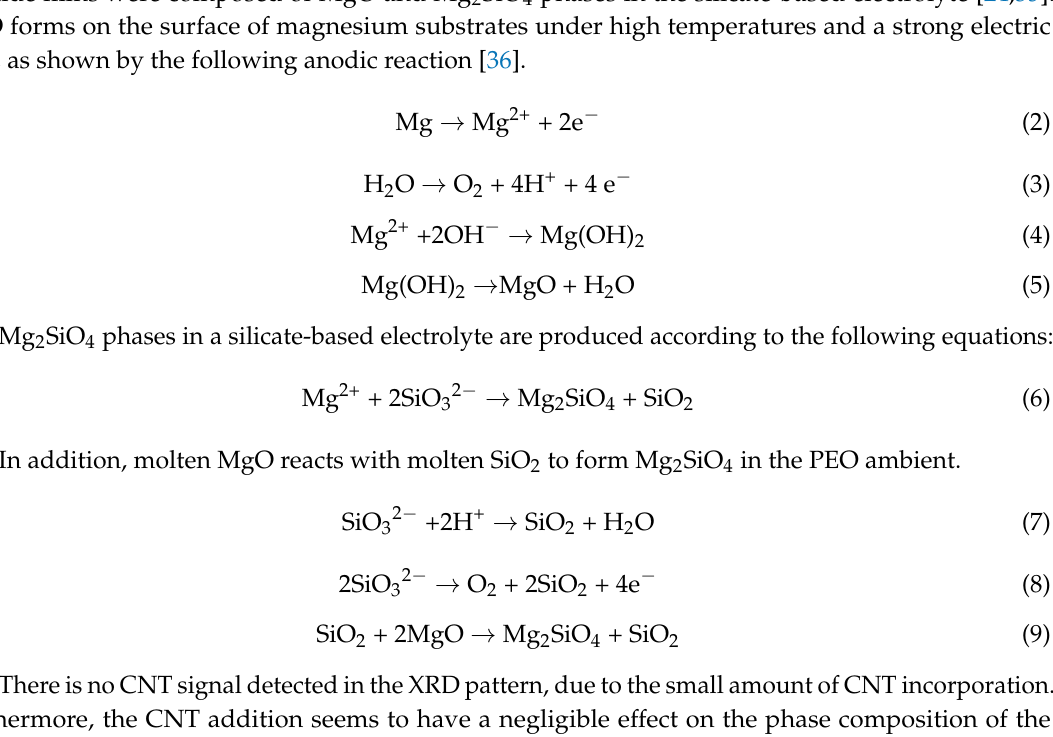
Figure 5. Cross-sectional SEM images of PEOcoated specimens formed in the electrolytes containing different amounts of CNT: ( a ) 0 g/L CNT; ( b ) 2.5 g/L CNT; ( c ) 5 g/L CNT; and ( d ) 10 g/L